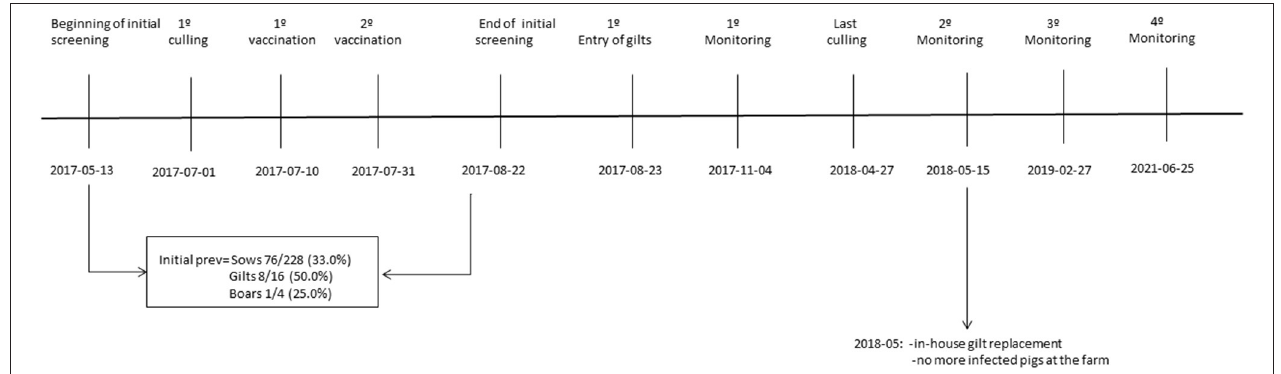
FIGURE 1 | The framework of the control strategies and dates of implementation.